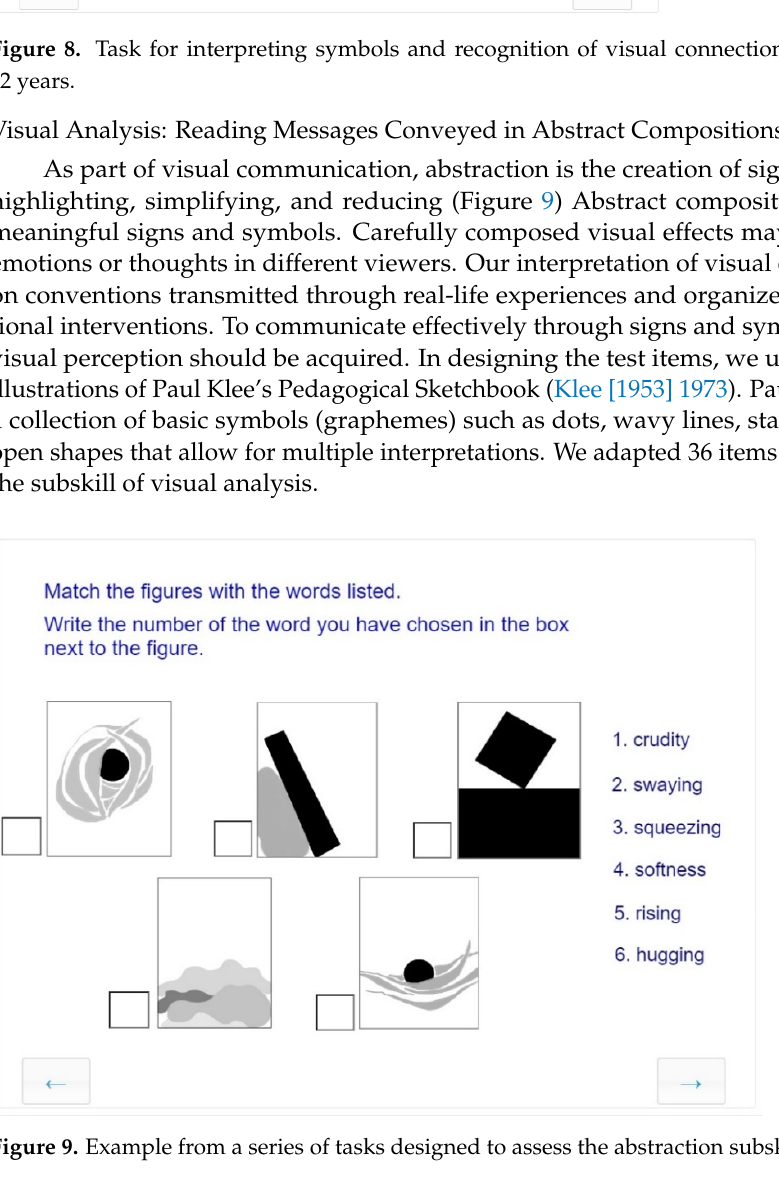
Figure 8. Task for interpreting symbols and recognition of visual connections for Grade 6, age 12 years.